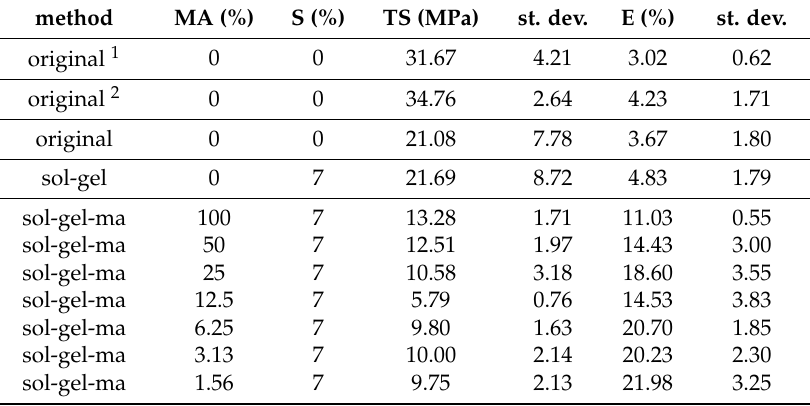
Table 2. Mean values of tensile strength (TS) and elongation at max (E) of films prepared in the preliminary experiment using different concentrations of maleic anhydride (MA) and sugar